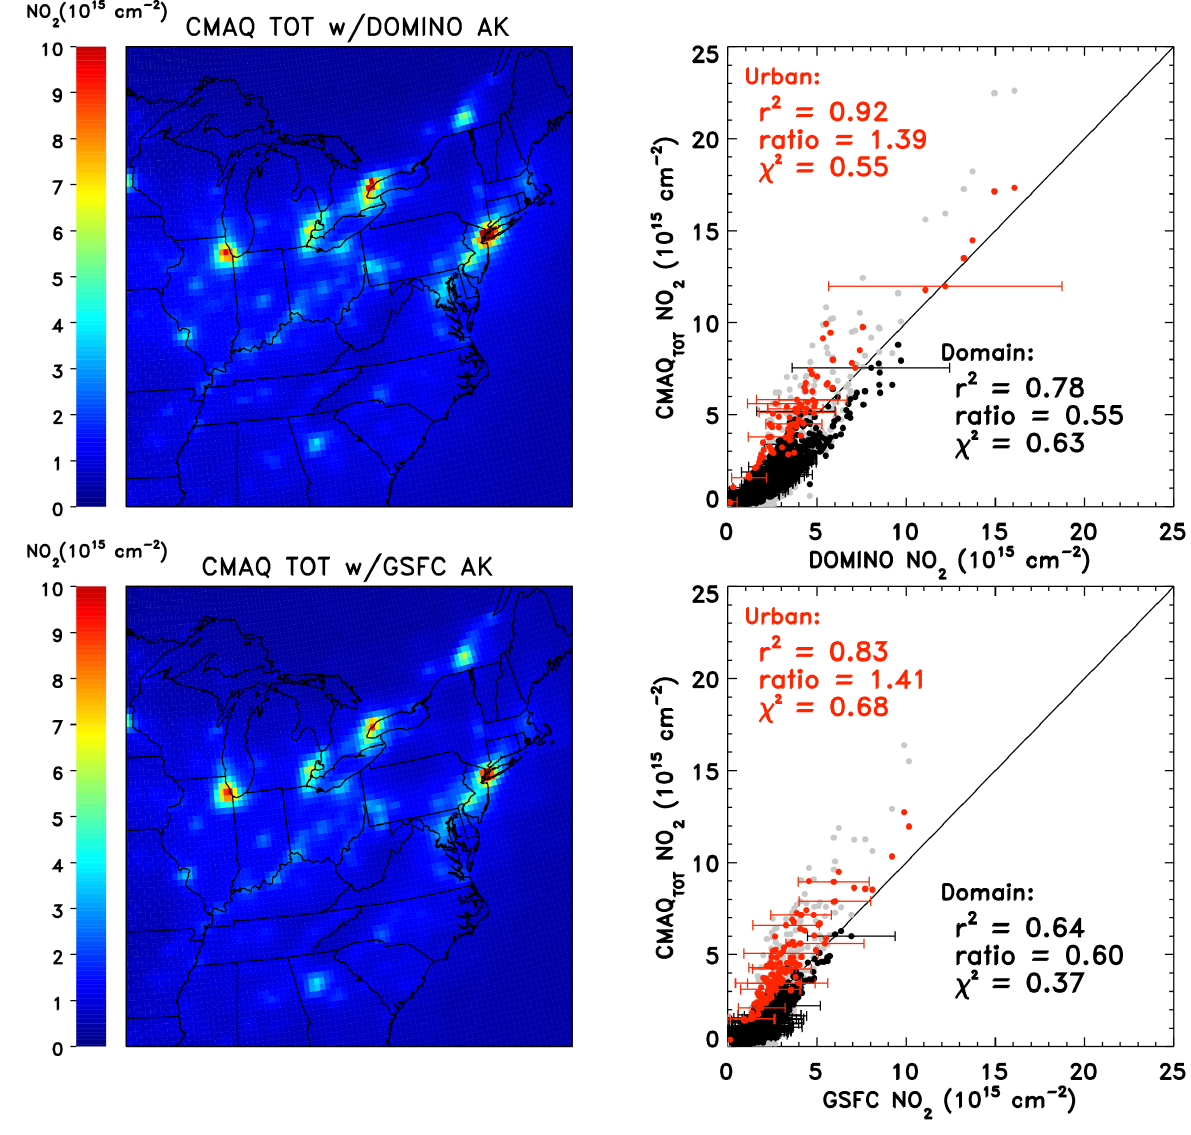
Figure 8. Same as Fig. 2 except model results include changes to NTR chemistry, a 50% reduction in the emissions of NO x from mobile sources, and updated biogenic emissions (CMAQ TOT ). Gray points on the scatter plots represent the results shown in Fig. 2 (right